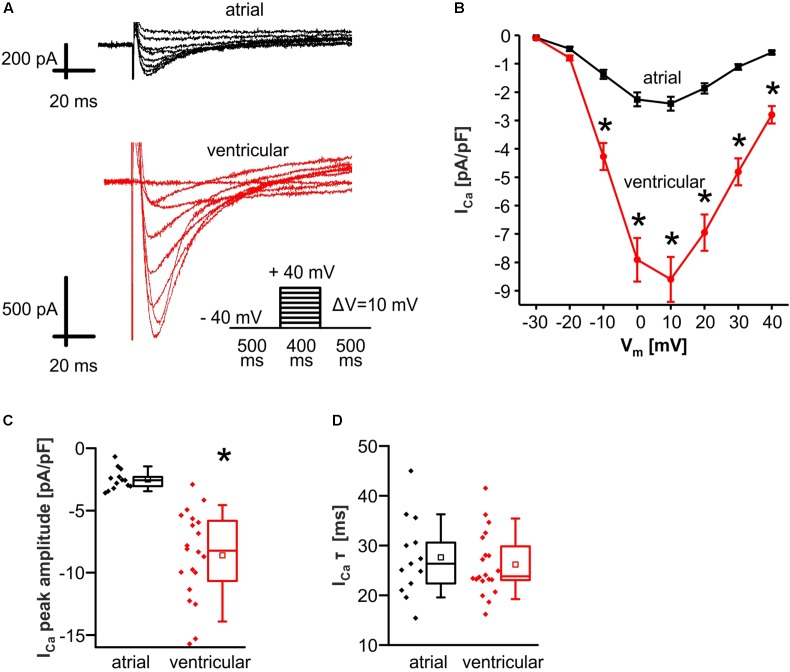
Reduced L-type Ca2+ current (ICa) in atrial versus ventricular myocytes. (A) Original tracings of ICa in atrial (upper panel) and ventricular (lower panel) myocytes. The applied stimulation protocol is depicted by the inset scheme. ICa was significantly reduced in atrial compared to ventricular myocytes over a voltage range between –10 mV and +40 mV as shown in the I–V-curve representing the mean values (B). (C) Median values of ICa peak amplitude in response to a voltage step to +10mV. (D) ICa inactivation kinetics were unaltered between both cell types. ∗p < 0.05 atrial vs. ventricular [two-way repeated measures ANOVA for (B)].